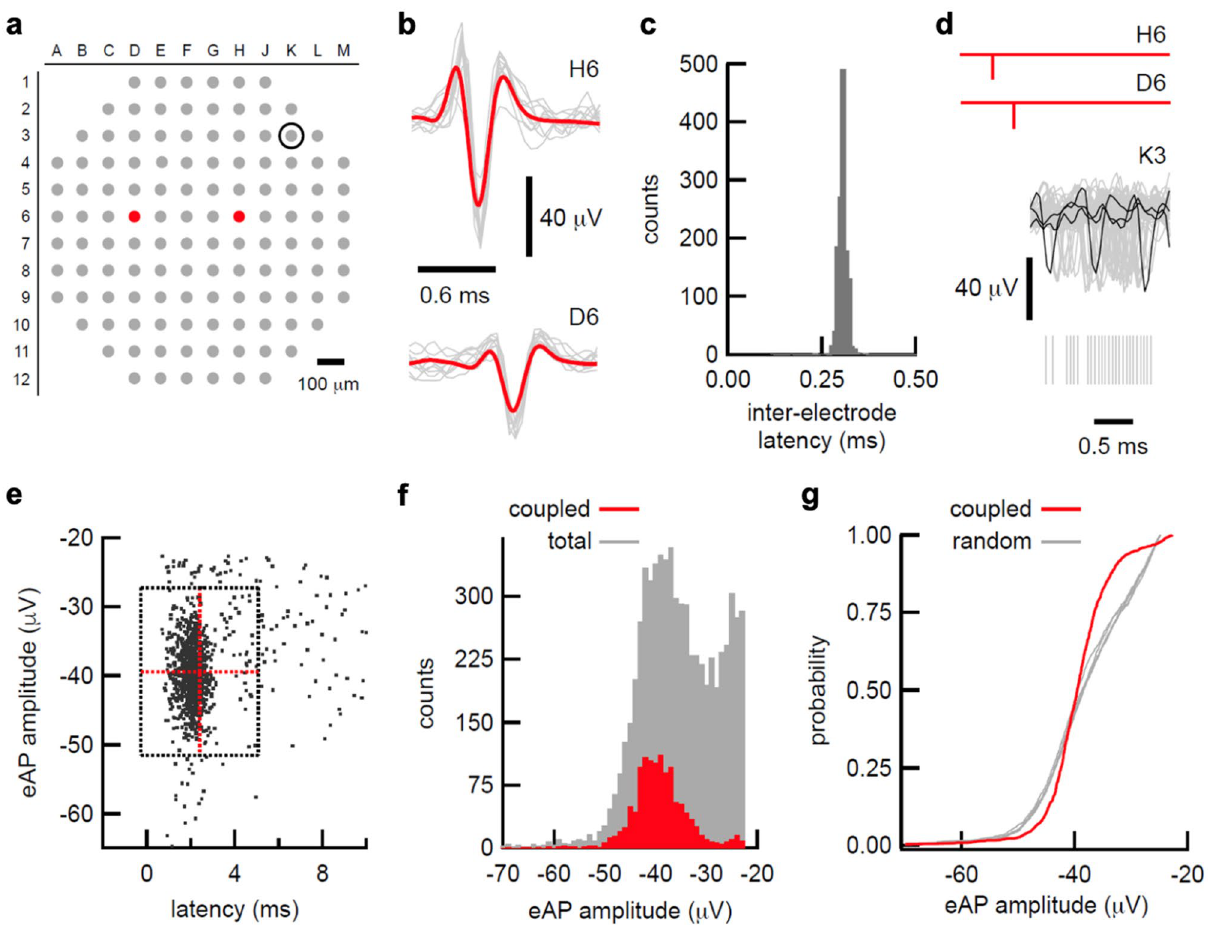
Figure 1. Propagation signals are a clock used to identify coupled eAP’s. ( a ) Map of electrode array used in these experiments. Two electrodes that detect single axon eAP propagation are shown in red. Electrode K3 is the location of the spike cloud that follows the propagation signal. ( b ) The eAP waveforms at H6 and D6 are shown. Individual eAPs are in grey; the average of 100 eAP waveforms is superimposed in red. ( c ) The distribution of inter-electrode eAP latency between H6 and D6. The high number of co-occurrences (n = 1360) and low coefficient of variation (0.078) are consistent with action potential propagation. ( d ) aligning the eAP co-occurrences at H6 and D6 (schematized in red) reveals a cloud of eAPs at K3. Twenty eAP waveforms from K3 are superimposed in grey, with 3 waveforms highlighted in black. The timing of 50 eAPs from K3 following the H6/D6 co-occurrence are shown as grey hash marks beneath eAP the waveforms. ( e ) the plot of eAP amplitude at versus time after H6/D6 co-occurrence shows a large cluster. All eAPs that occurred between 0.5 and 10 ms after the H6/D6 co-occurrence are displayed. Red lines indicate the mean latency and eAP amplitude, respectively. Horizontal and vertical grey lines indicate two standard deviations of the mean for each dimension. ( f ) the amplitude distribution of the spikes in K3 that occurred within 0.5 to 10 ms following the H6/ D6 co-occurrence (red bars) are superimposed on the all-points spike amplitude distribution histograms from electrode K3. ( g ) cumulative distribution of the coupled spikes in K3 (red line) superimposed on the cumulative distributions from 5 randomly selected groups of amplitudes from the all-points distribution from K3, showing that the amplitudes of the coupled eAPs were not randomly selected from the full amplitude